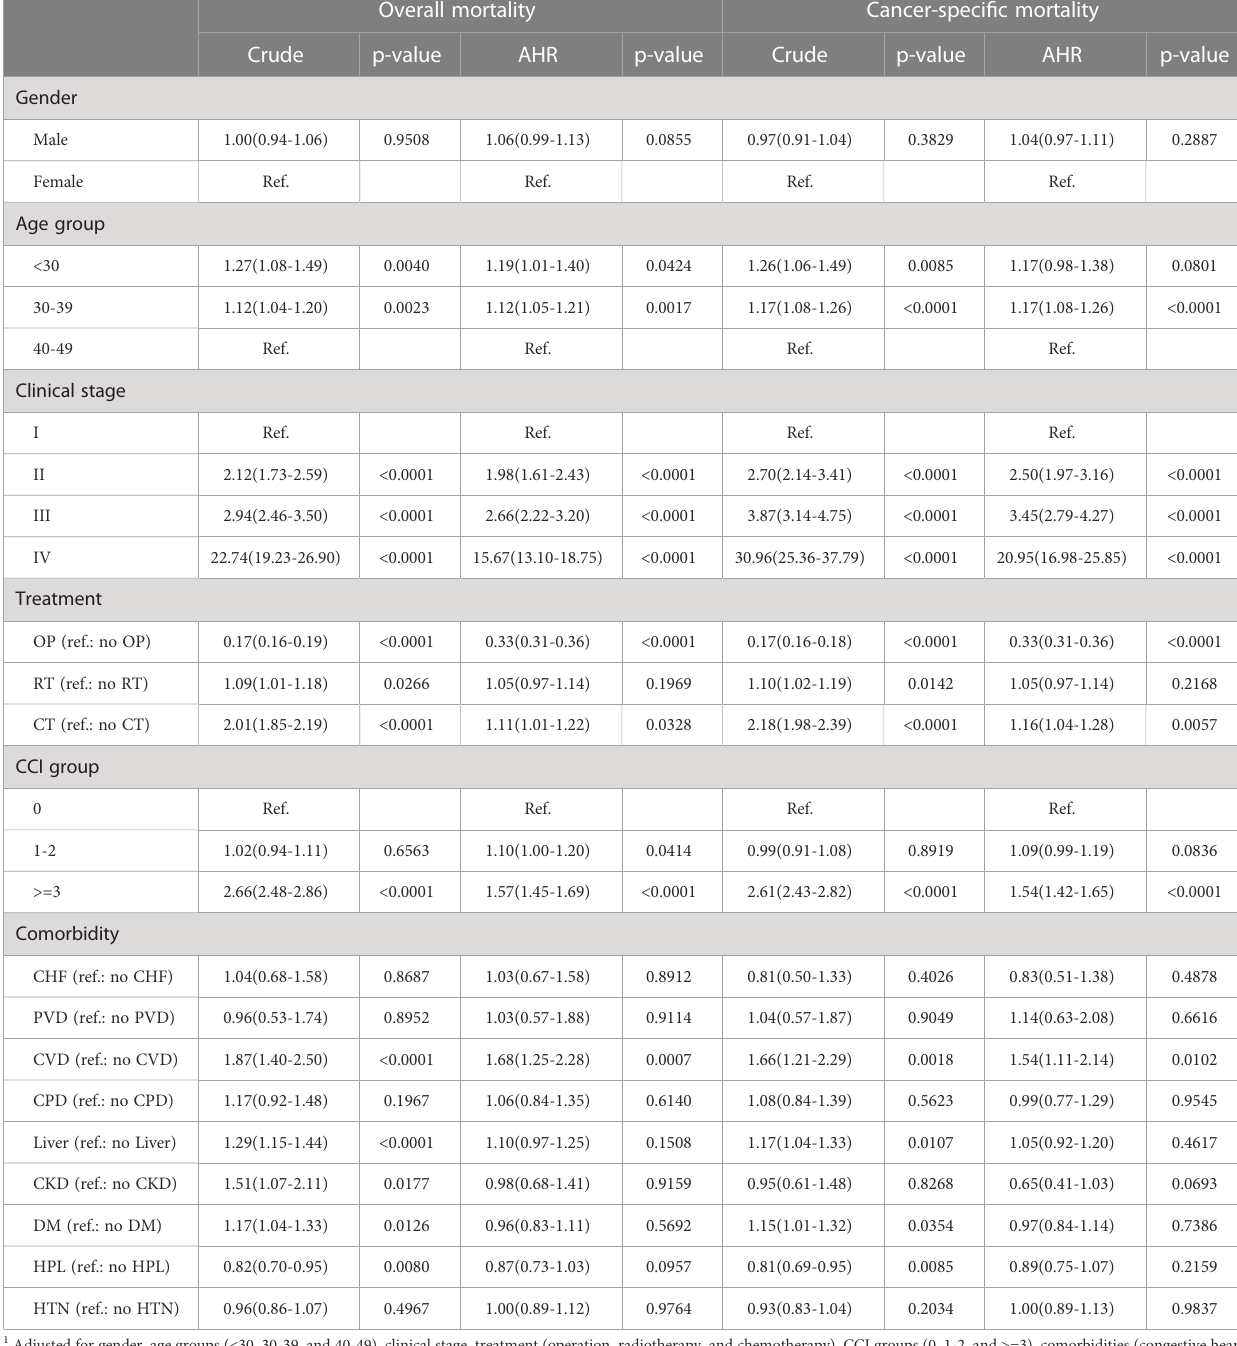
TABLE 2 The risk of overall and cancer-speci fi c 5-year mortality among EO-CRC